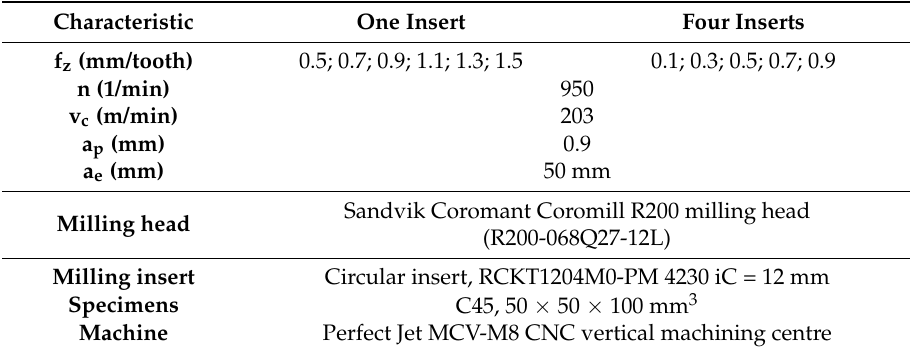
Table 2. The applied technological